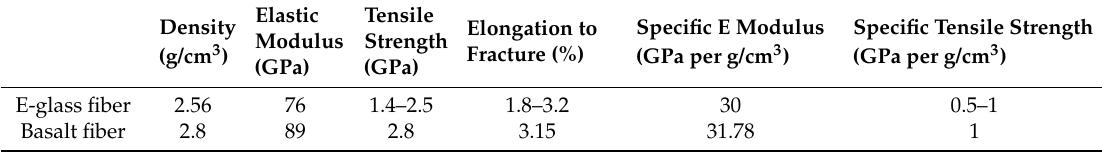
Table 1. E-glass and basalt fiber properties